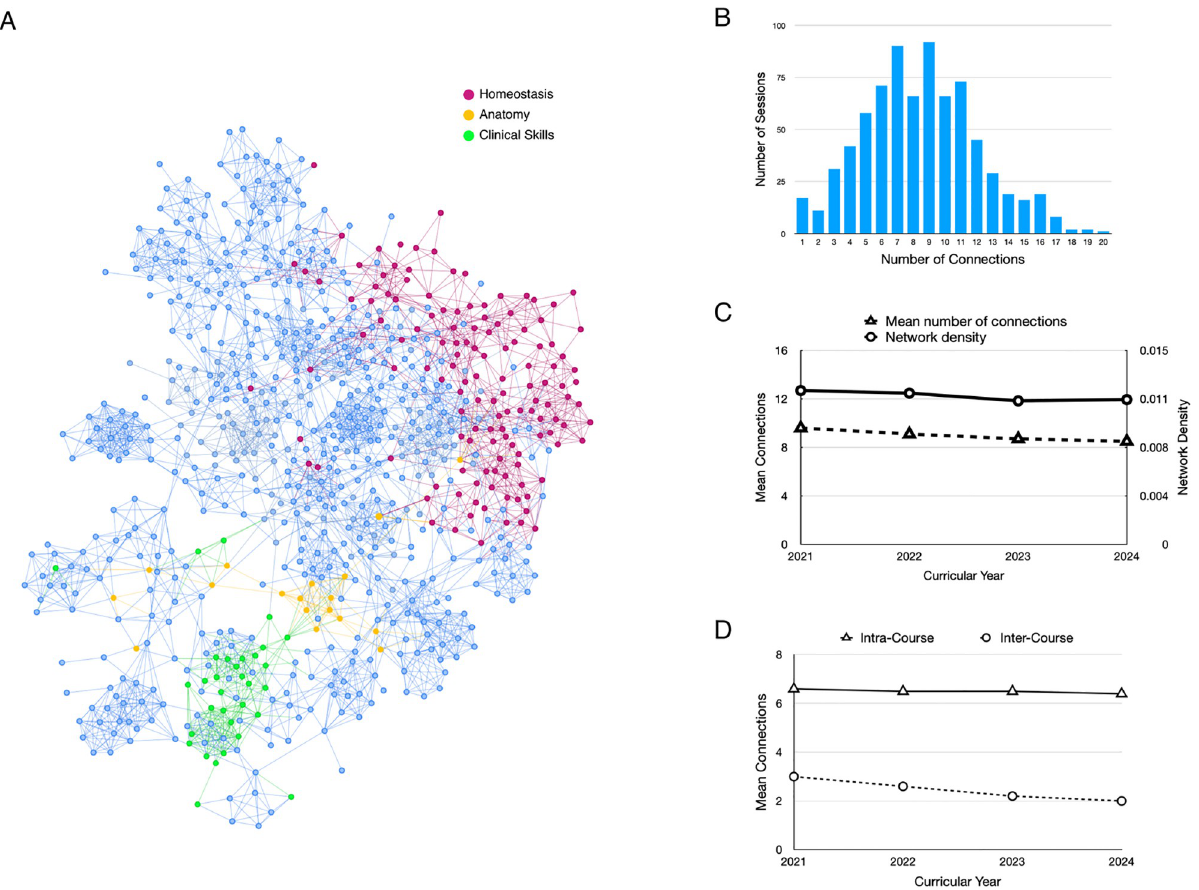
Fig 4. Integration of content has declined over the past four years. A. A network map of sessions in the pre-clerkship curriculum. Each node represents a session and a line between nodes indicates the sessions cover related content. Sessions from three courses have been highlighted: Clinical Skills (green), Anatomy (yellow) and Homeostasis (red). The network map can be accessed online at http://medcurriculum.org/pre_clerkship_network. B. Distribution of connections for sessions. The histogram shows the number of sessions that are connected to The map Integration for each class year was determined by the two different metrics of connectivity in network graphs of sessions. Network density (circles) is measure of the fraction of all possible connections in a network graph that exist in the graph. Mean connections (triangles) is the mean number of connections for each session in the graph. Both show a slight decrease over the past four years. B. Integration within courses has remained stable while integration between courses has declined. The mean number of connections between sessions in the same course (triangles) and between sessions in different courses (circles) are